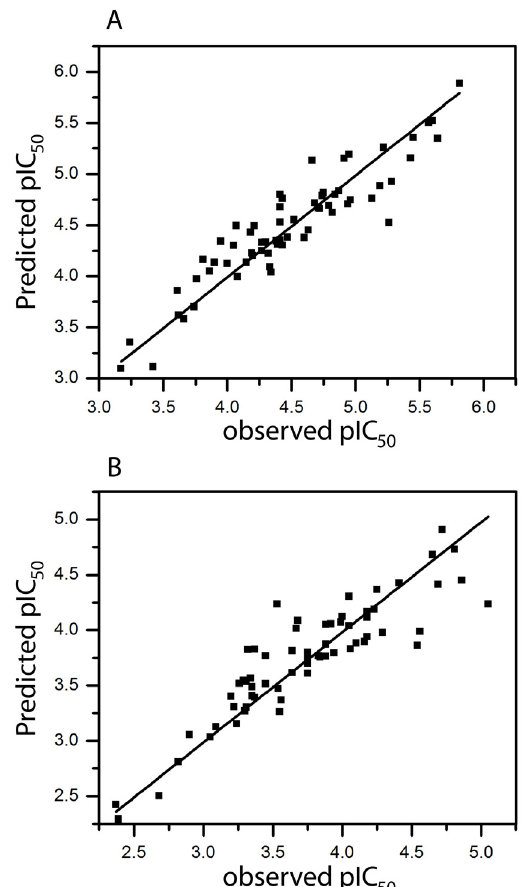
Figure 1. Plot of predicted versus observed pIC binding (model 63, Table 1) and ( B ) [ 3 H]MK-801 binding in presence of 30 µM spermine (model 63, Table